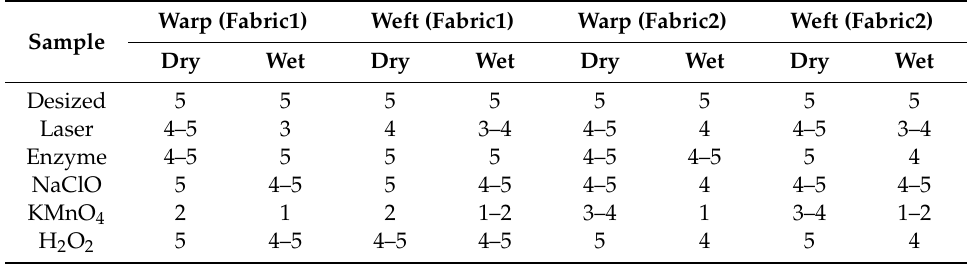
Table 7. Color fastness to rubbing of denim fabrics with di ff erent bleaching